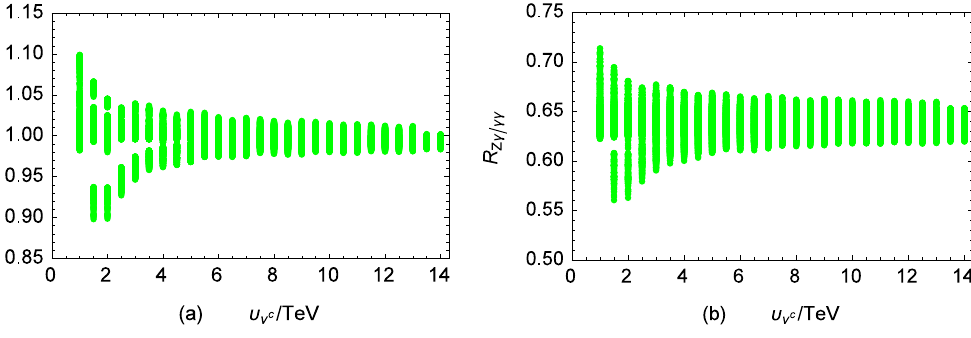
Figure 6 . The signal strength (cid:22) ggF